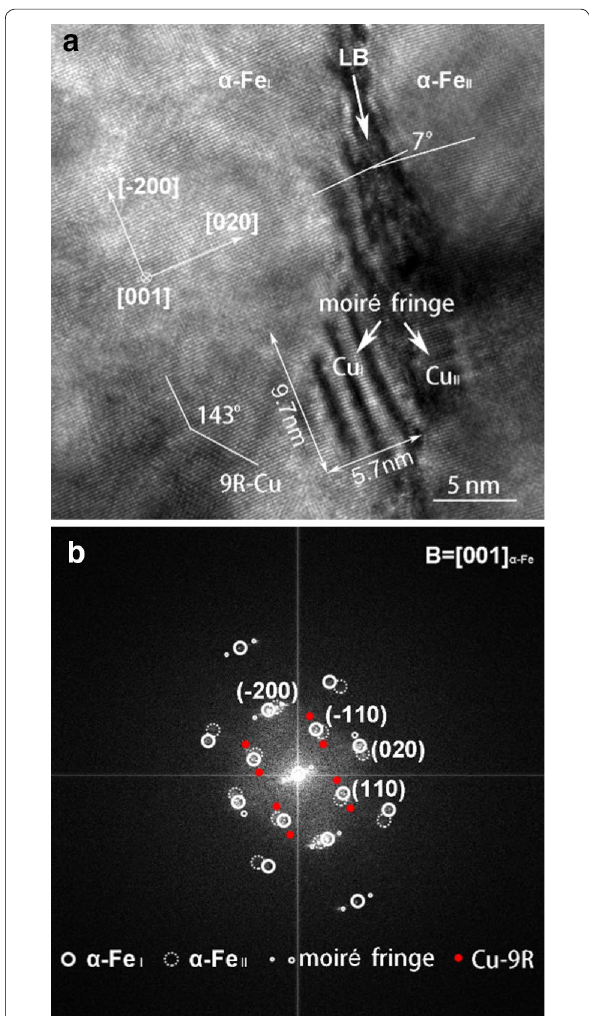
Figure 2 a HRTEM image of Cu precipitates formed at a martensite lath boundary and in α-Fe matrix; b FFT pattern of a , showing the presence of 9R Cu